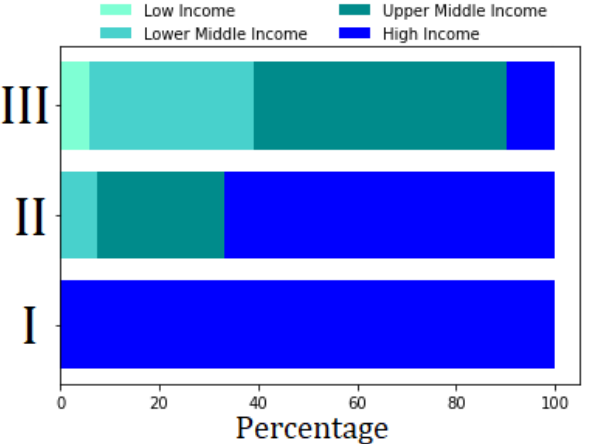
Figure 4. Composition of StartupBlink network communities in terms of World Bank income groups, highlighting an emerging hierarchy, in descending order from I to III, in terms of